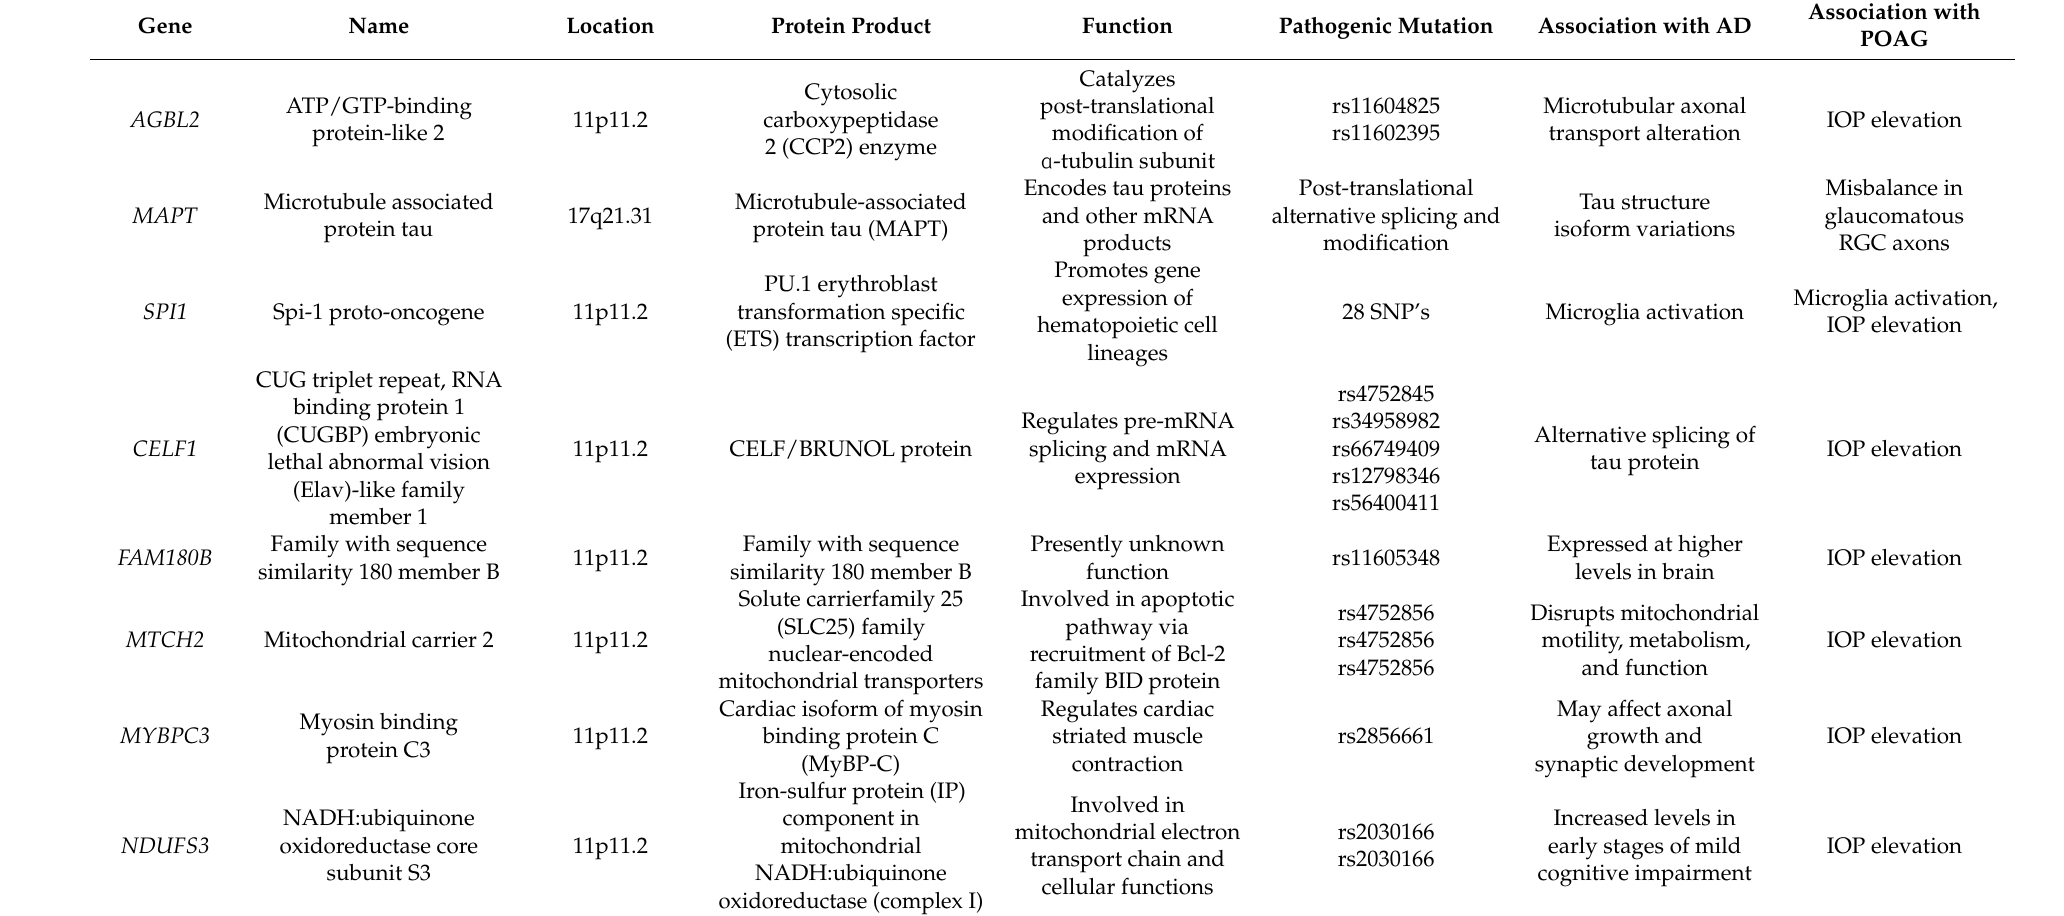
Table 1. Shared genes in studies of connection between Alzheimer’s disease and primary open-angle glaucoma [8,9,21,22,40,41,59–79].